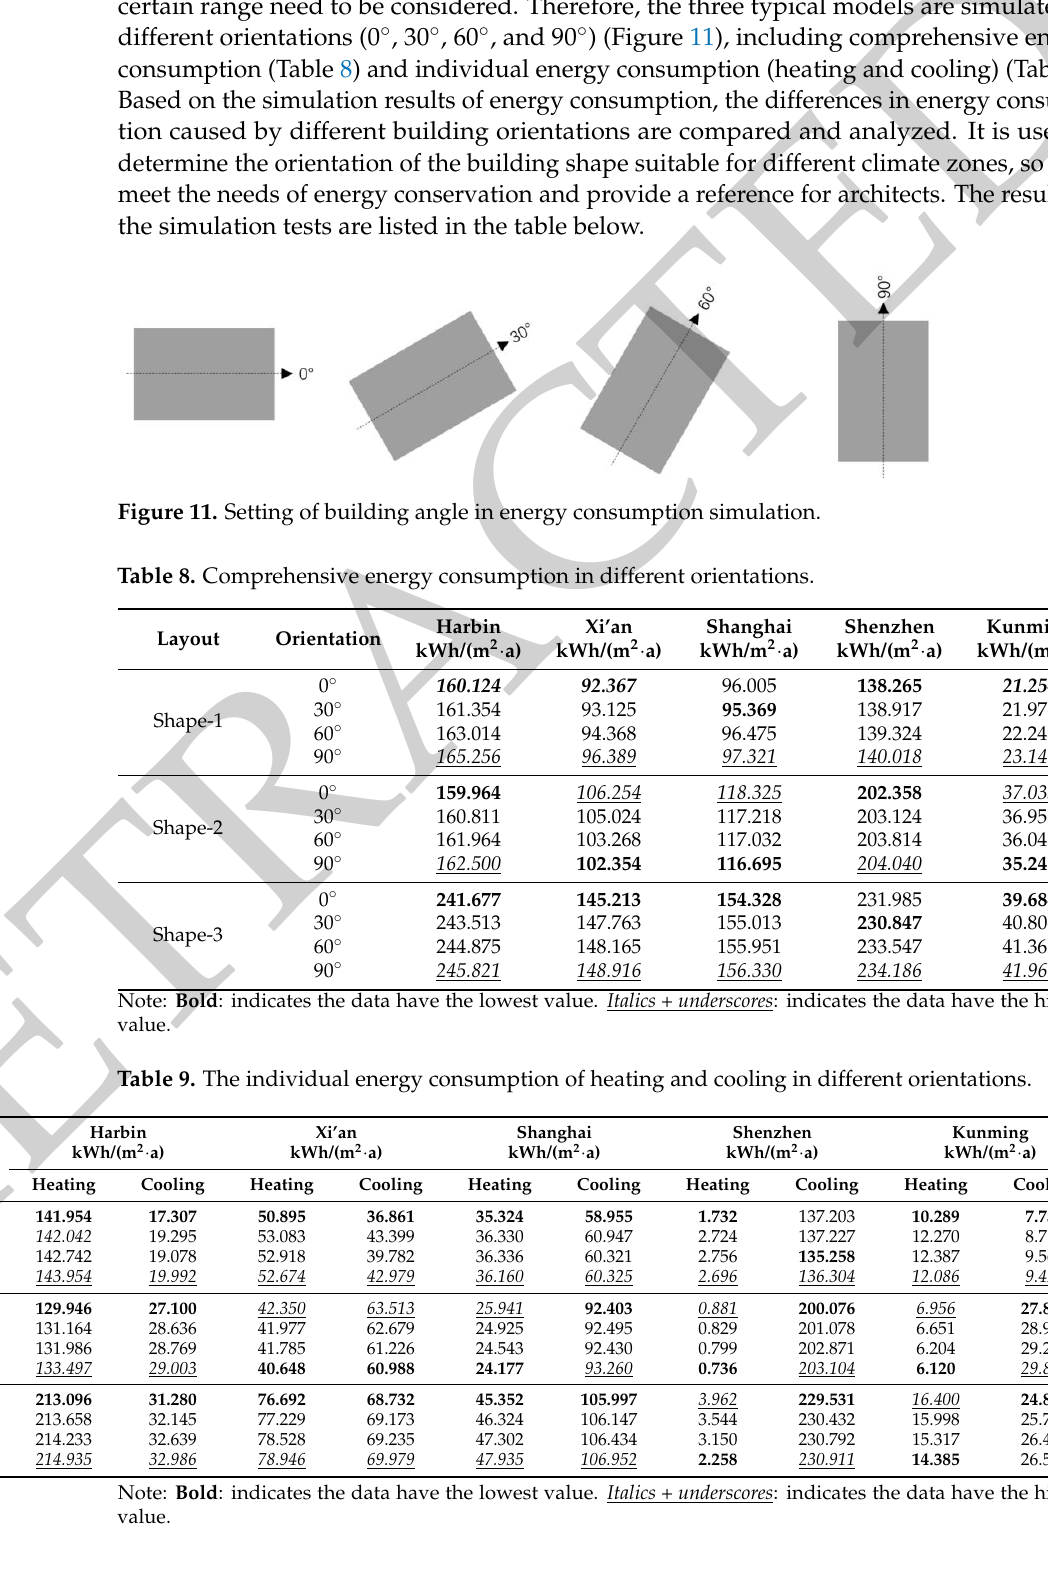
Figure 10. Energy saving rate of three models in five climate zones.